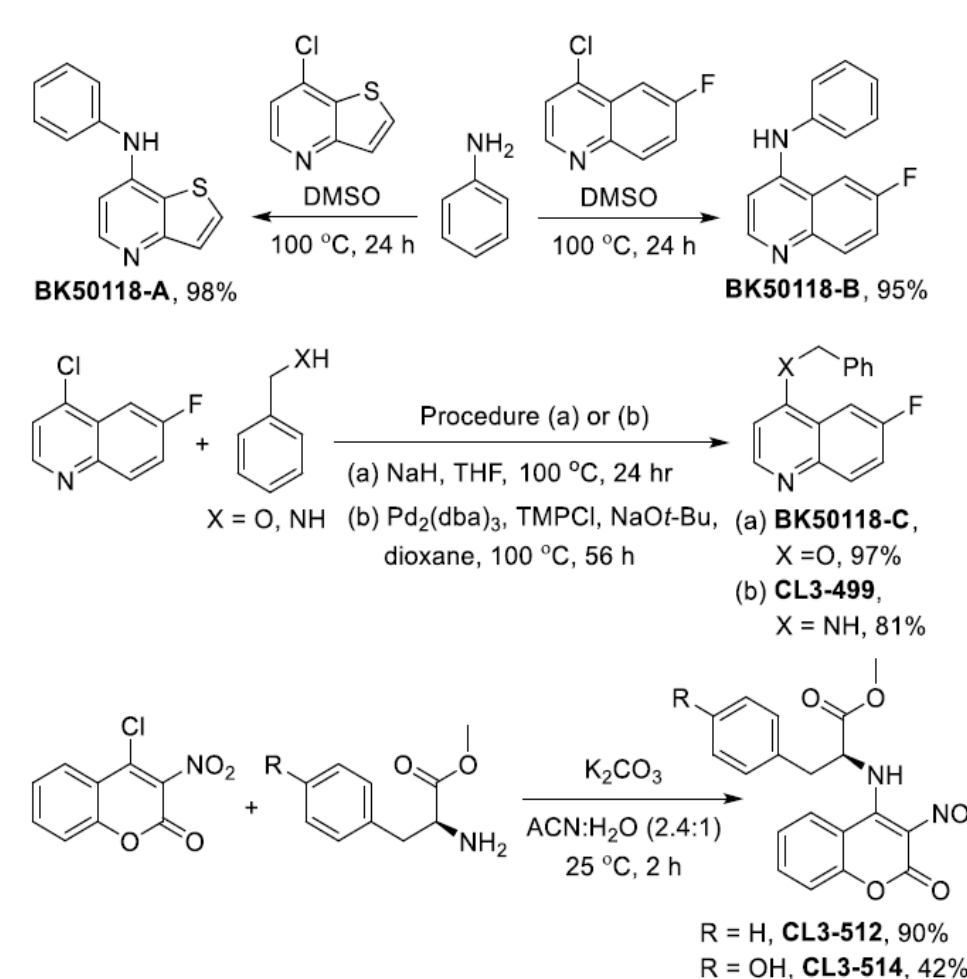
Figure 1. Scheme of synthesis of spautin-1 analogues.